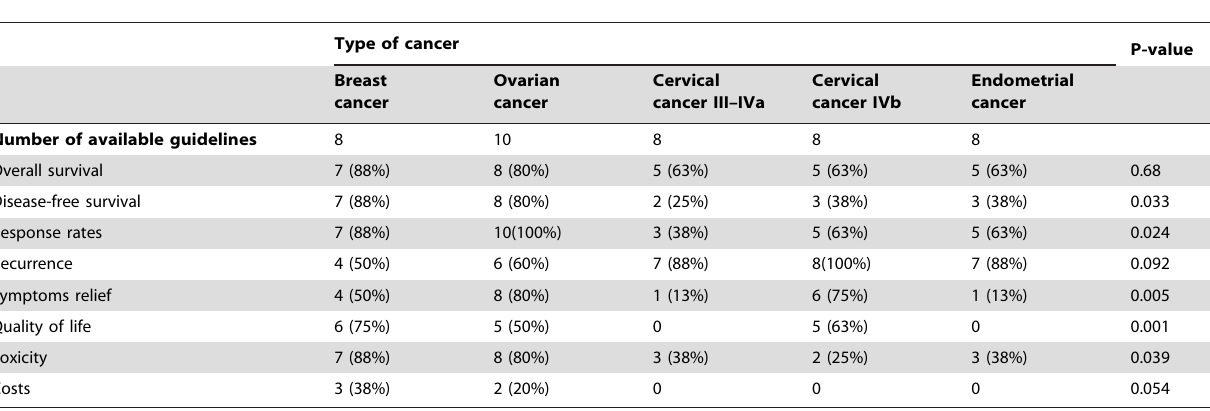
Table 4. Outcomes discussed in guidelines for chemotherapy for advanced gynecological